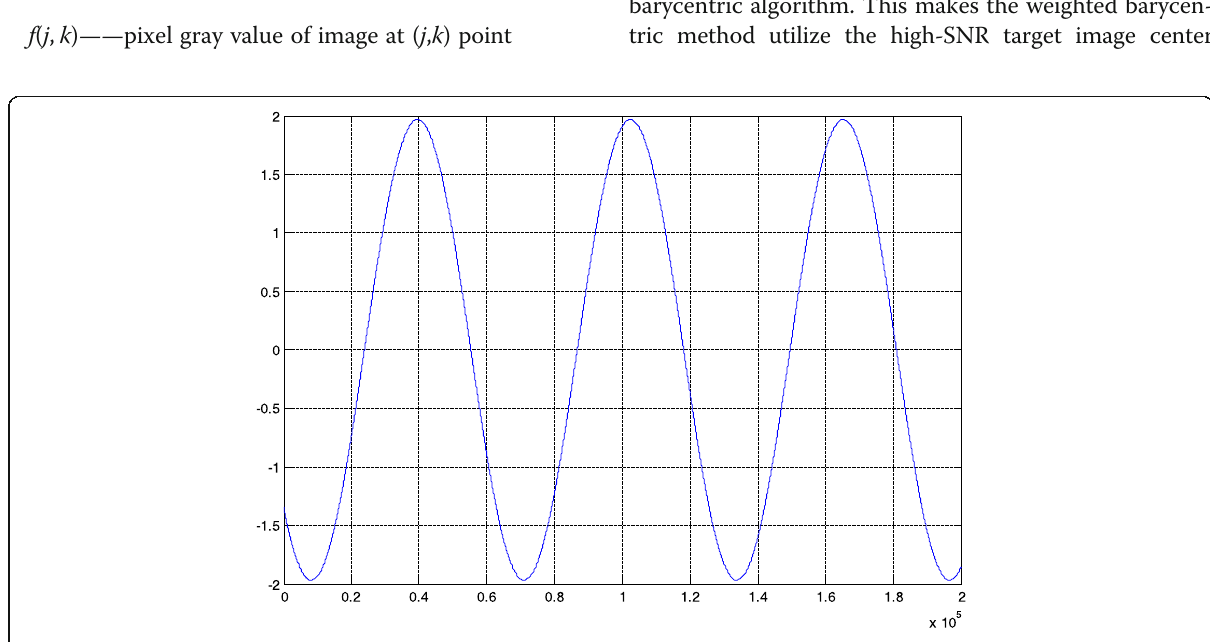
Fig. 11 Main system tracking error simulation curve